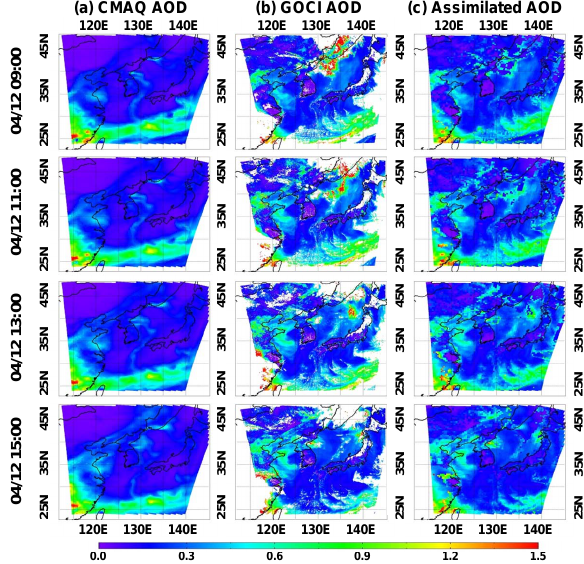
Fig. 5. As Fig. 3, for a non-LRT event on 12 April 2011. This case was determined as non-LRT because the main AOD plumes were transported into over northwestern Pacific Ocean, not over the Ko- rean peninsula and/or